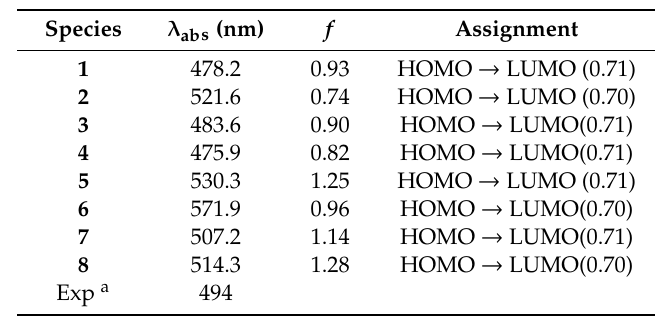
Table 3. Predicted longest wavelengths of absorption, corresponding oscillator strength f , and main assignment of 1 – 8 at the TD- PBE0 / 6-31G (d,p) // PBE0 / 6-31G (d,p) level.